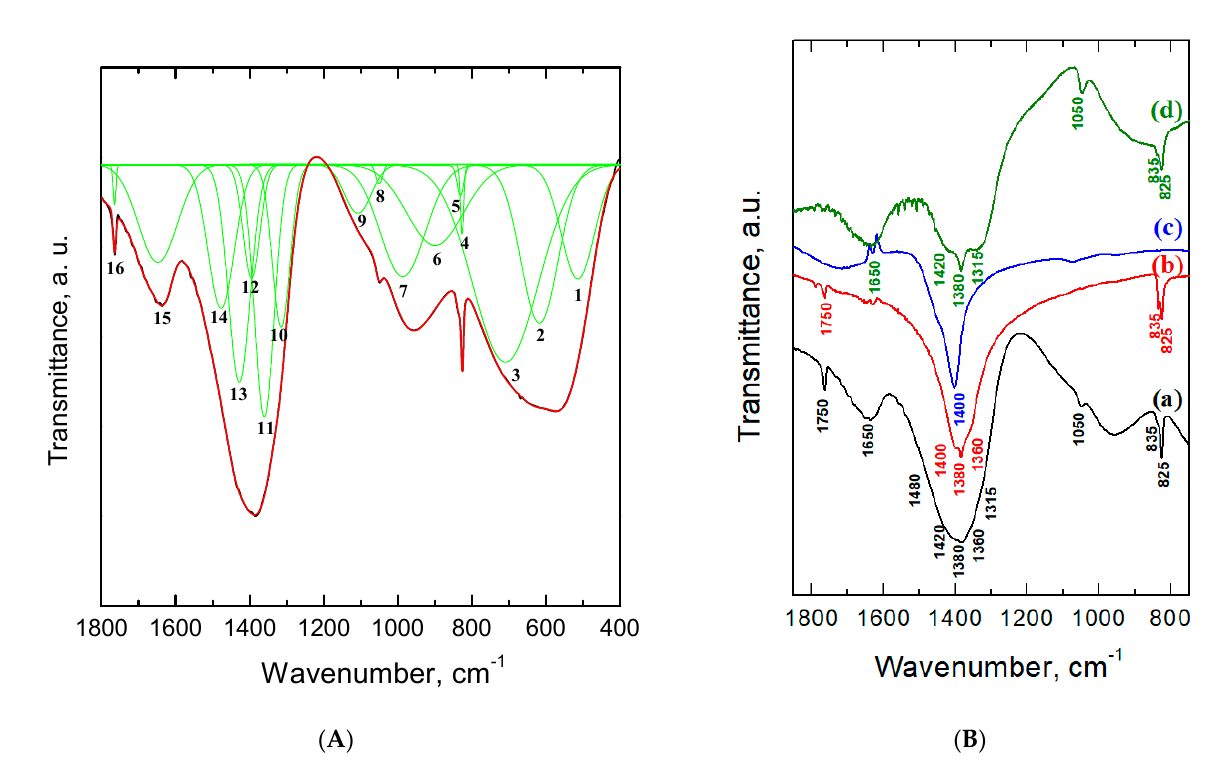
Figure 3. Deconvolution (green line) of the IR spectrum (red line) of the Al-5 sample ( A ) and comparison of the IR spectrum with precursors ( B ): (a) Al-5; (b) NH 4 NO 3 ; (c) NH 4 Cl and (d) Al(NO 3 ) 3 · 9H 2 O. Table 1. Wavenumbers of IR bands of Al-5